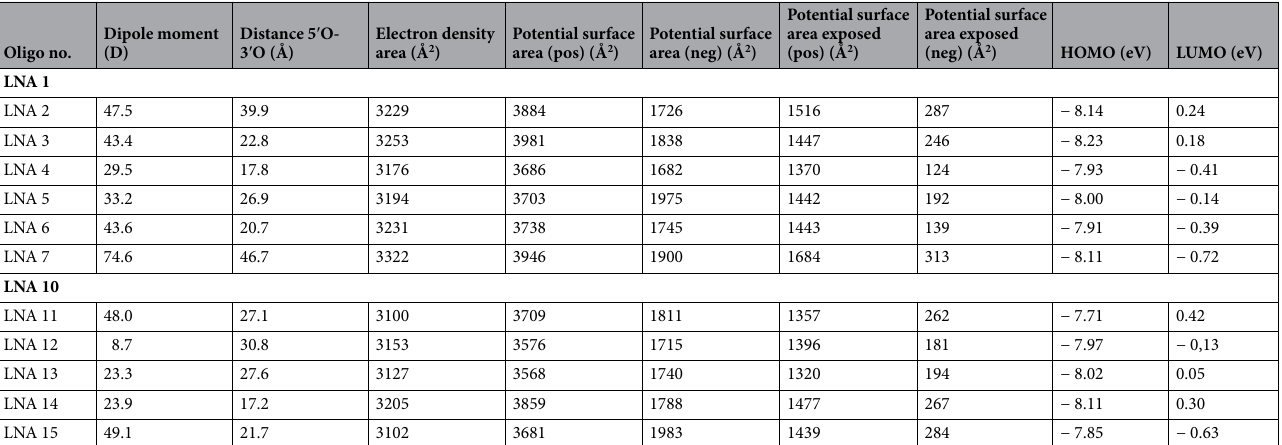
Table 2. Calculated biophysical parameters of the 11 stereo-defined LNAs. The columns from left to right shows the LNA numbering, the Dipole moment in Debye (D), the distance measured from the 5 ′ -O (in the 5 ′ -OH) to 3 ′ -O (in the 3 ′ -OH), the area measured on the surface of the electron density of iso- value 0.002 electrons/a.u 3 . Next two columns show the area of the positive and the negative electrostatic potential surfaces of numerical value 83.68 kJ/mol. Similar results are shown for the exposed potential surfaces. Last two columns contain the energies of HOMO and